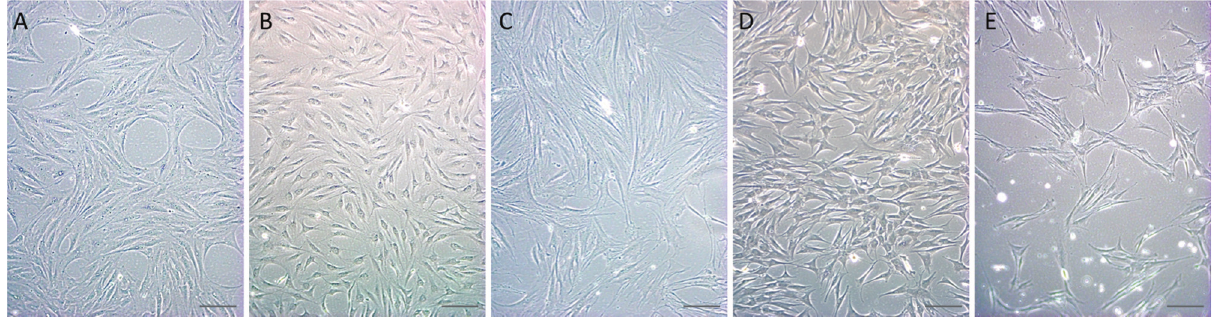
Figure 1 - Morphology of cultures. Cultures established from all organs and tissues presented the typical fibroblastoid morphology of mesenchymal stem/stromal cells: (A) brain; (B) adipose tissue; (C) bone marrow; (D) liver; (E) pancreas. Scale bar = 50 (cid:2) m. Table 2 - C. minutus tissues from which adherent cultures were established and characteristics analyzed or assays performed. The results are described in the text.